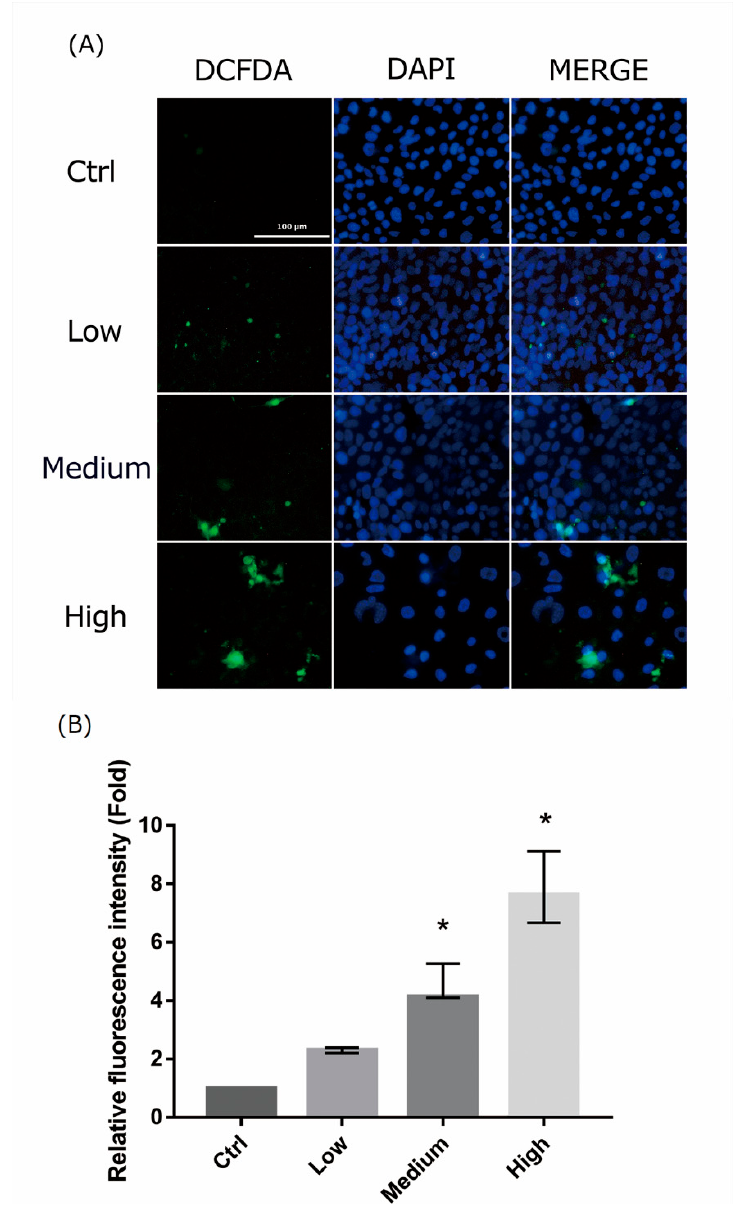
Figure 4. Reactive oxygen species assay in 661W cells after exposure to liquid crystal display (LCD) with different ocular energy exposure index (OEEI) for 3 days. (A) 2',7'-dichlorodihydrofluorescein diacetate (H2DCFDA) was added to 661W cells after exposure to LCD with low, medium, and high OEEI. The images were captured by florescence microscopy. Bar = 100 μ m. (B). Quantitative analysis of the images obtained from fluorescence microscopy using image-processing software (Image-J). Fluorescence level in the control group was arbitrarily set as 1. Ctrl: control group, no light exposure; All data represent the median and the interquartile range. *p < 0.05 compared to the control group by Kurskal-Wallis test with post hoc Dunn test; n = 3 in each group.